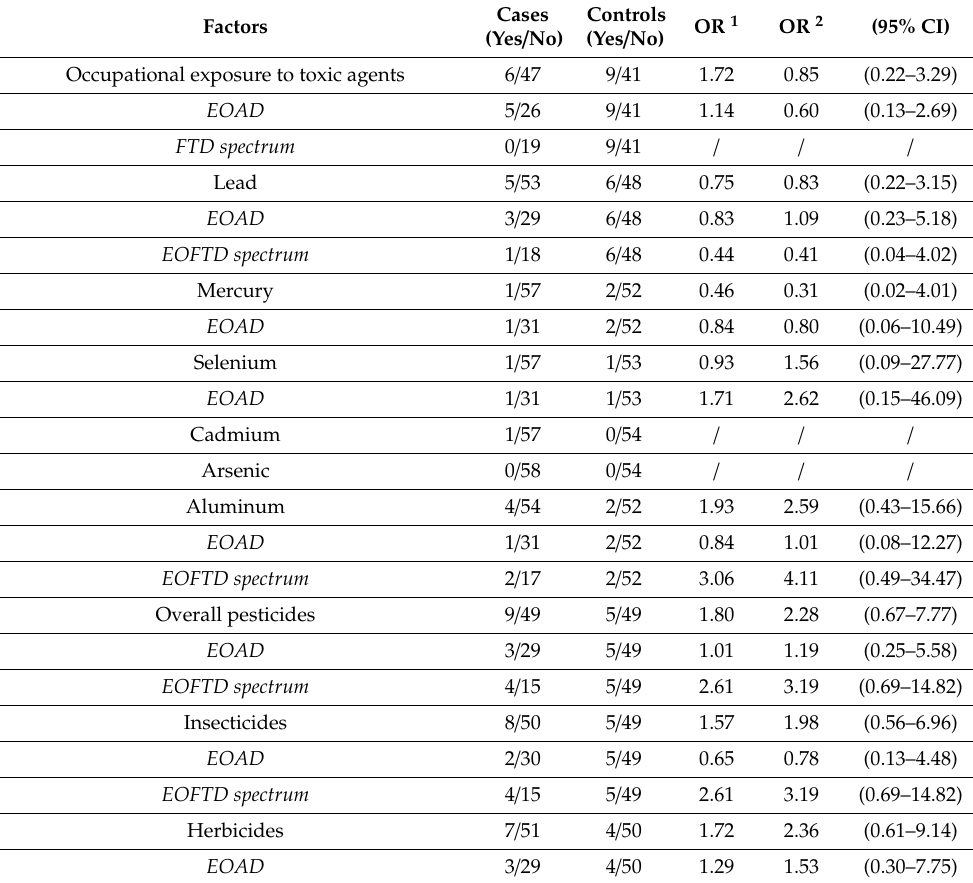
Table 4. Odds ratios (ORs) with 95% confidence intervals (CIs) for early-onset dementia (EOAD, early-onset Alzheimer’s dementia; EOFTD, early-onset frontotemporal dementia) related to occupational exposure to toxic